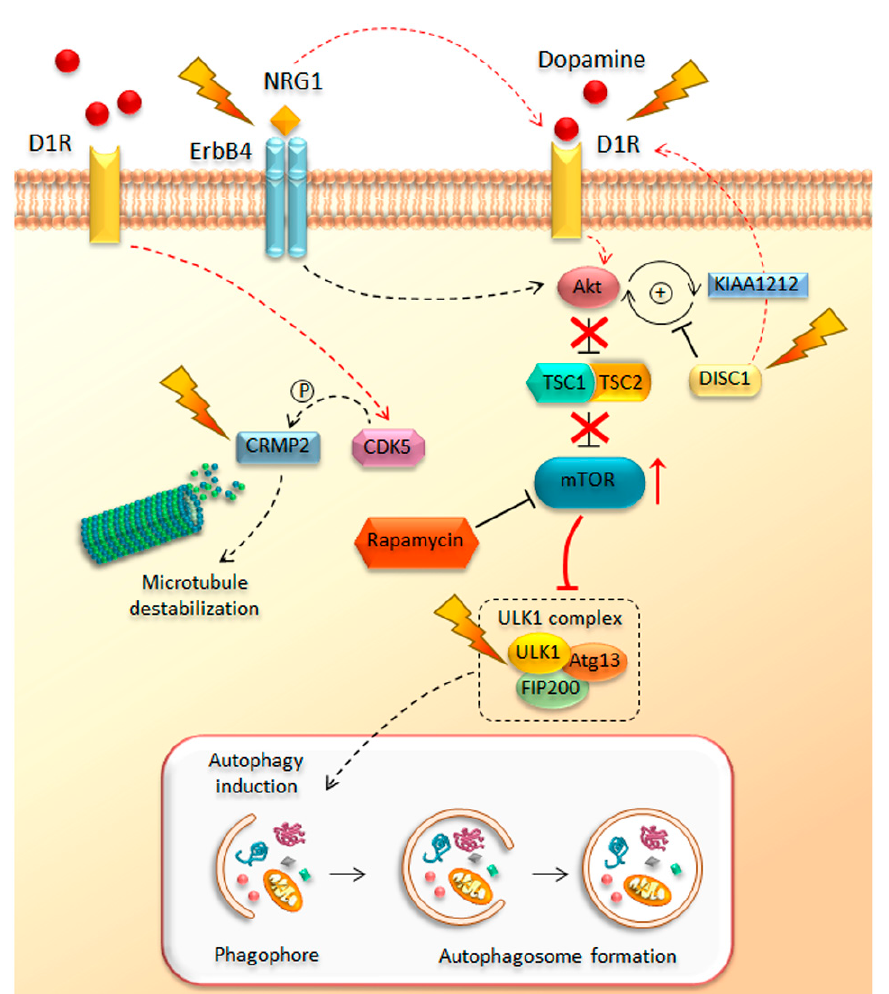
Figure 3. The Akt/mTOR pathway in schizophrenia. The cartoon summarizes key proteins involved in schizophrenia (lightning bolts), which converge on the overactivation of the Akt/mTOR pathway. These include disrupted in schizophrenia 1 (DISC1), neuregulin-1 (NRG1)/avian erythroblastosis oncogene B4-like protein (ErbB4), and collapsin response mediator protein 2 (CRMP2), as well as dopamine D1 receptors (D1R), which in turn are modulated by DISC1 and NRG1/ErbB4. Table 1. Altered proteins converging on the mammalian target of rapamycin (mTOR) pathway during schizophrenia and methamphetamine addiction. DISC1—disrupted in schizophrenia 1;